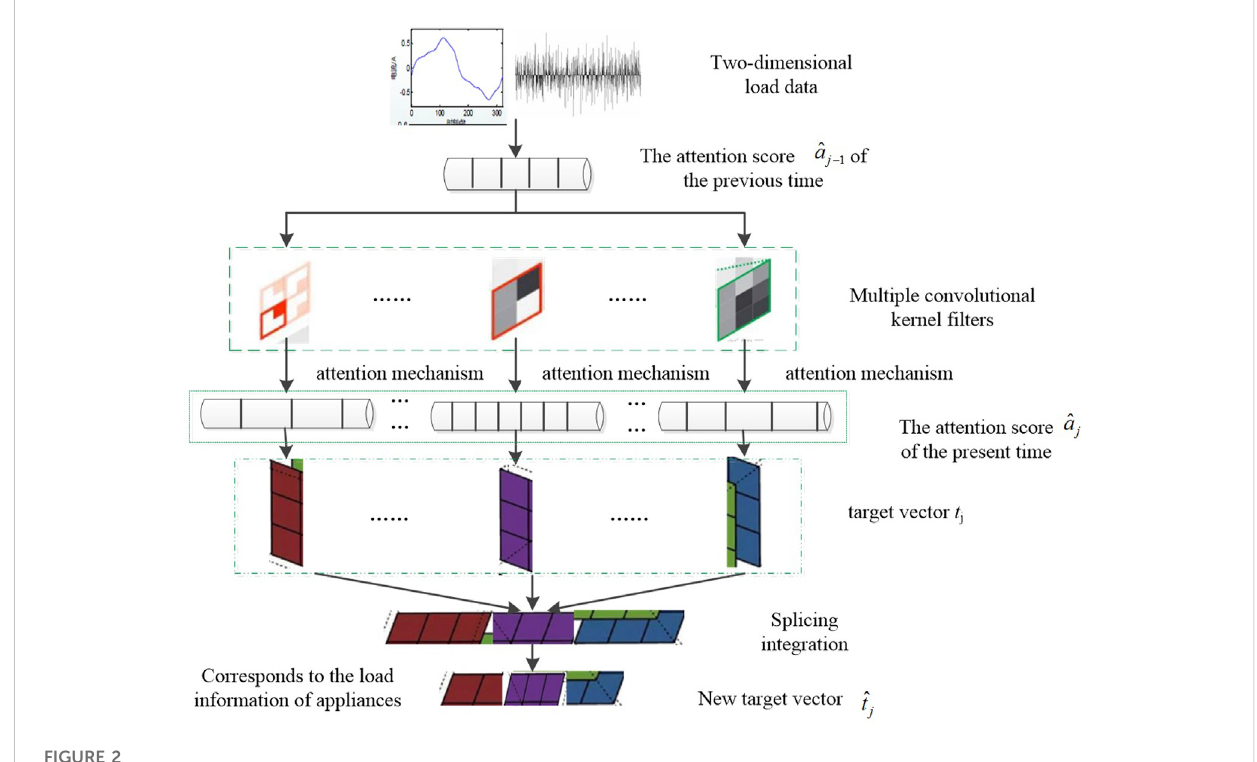
FIGURE 2 Non-intrusive load decomposition model of resident by